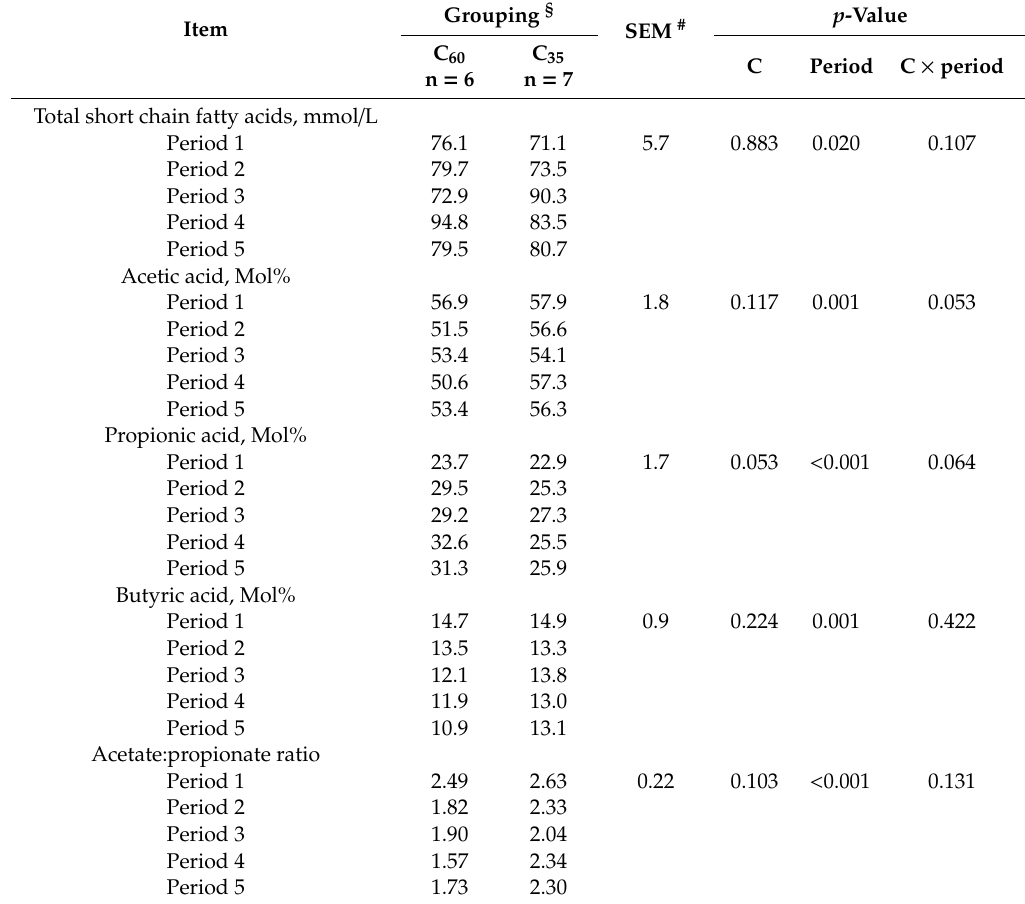
Table 6. E ff ects of concentrate feed proportion in the diet (C) and period on short chain fatty acids, as well as on acetate:propionate ratio and ammonia-nitrogen (ammonia-N) concentration during period 1 (weeks 1–2 postpartum), period 2 (weeks 3–4 postpartum), period 3 (weeks 5–6 postpartum), period 4 (weeks 7–8 postpartum) and period 5 (weeks 9–10 postpartum) in the treatment groups. p -Value Grouping § Item SEM # C 60 Period C × period n = 6 Total short chain fatty acids, mmol / L Period